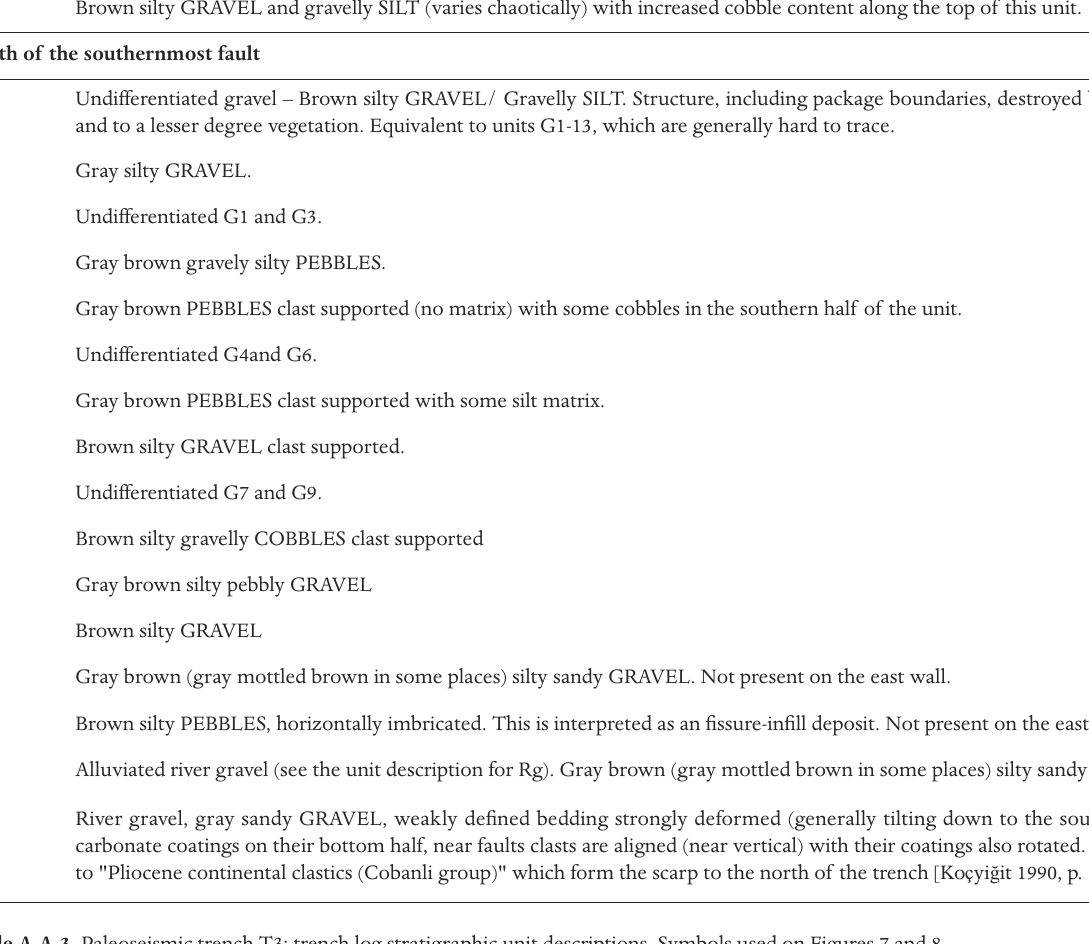
Table A.A-3. Paleoseismic trench T3: trench log stratigraphic unit descriptions. Symbols used on Figures 7 and